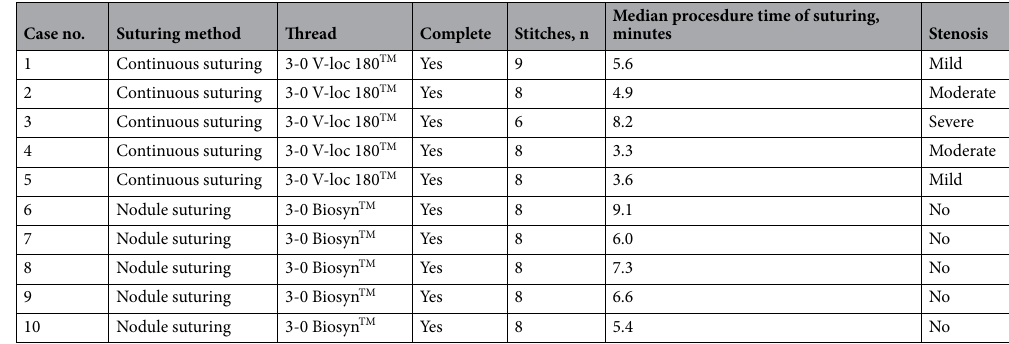
Table 1. Outcomes of endoscopic hand-suturing of rectal anastomosis in an ex vivo porcine model.